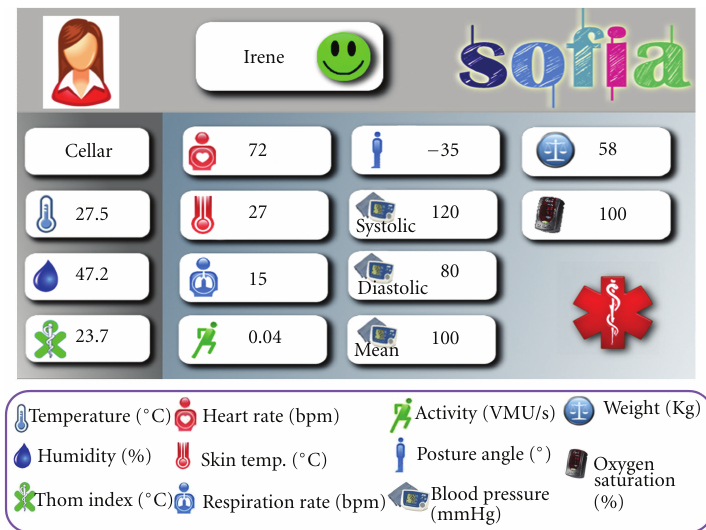
Figure 5: Health care monitoring GUI.